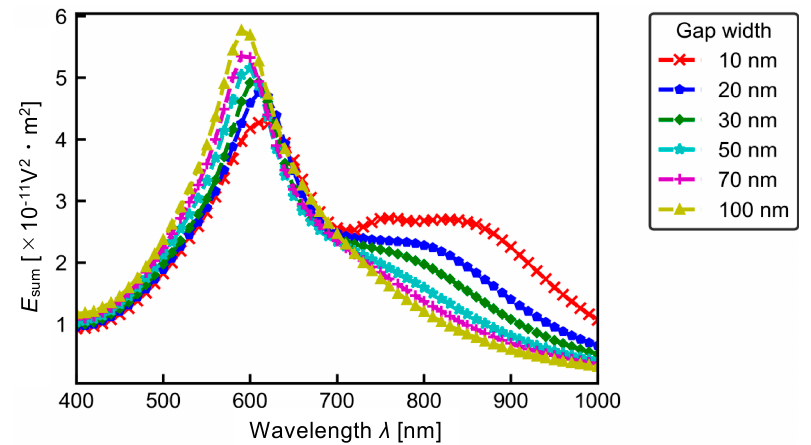
Figure 8. Maximum temperature T max in the numerical domain.